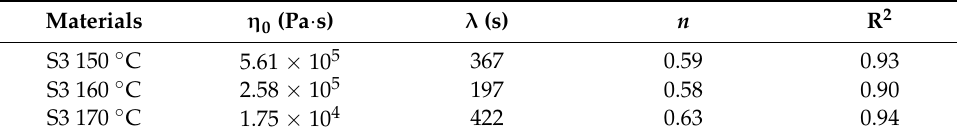
Figure 12. Storage (closed symbols) and loss (open symbols) modulus of ( a ) temperature sweep test and ( b ) strain amplitude sweep test for S3. Table 4. Fitting parameters of the Carreau model for S3 under various